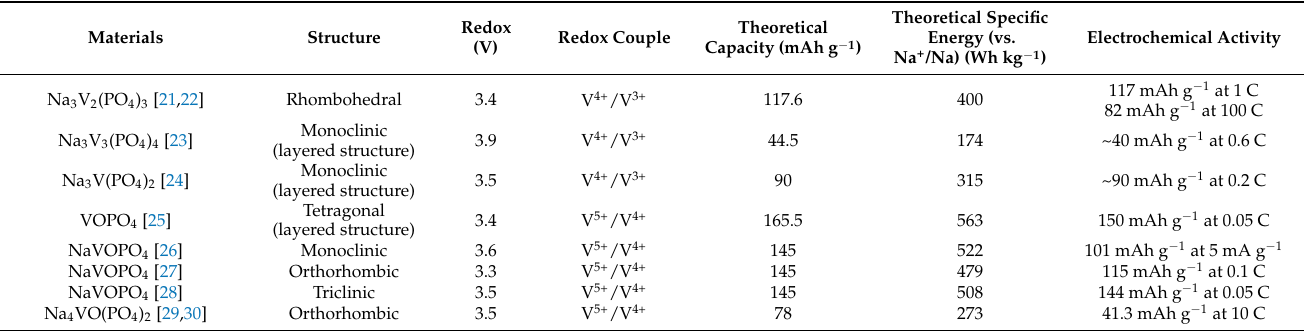
Table 1. A comparison of V-based polyanionic compounds as cathode materials for